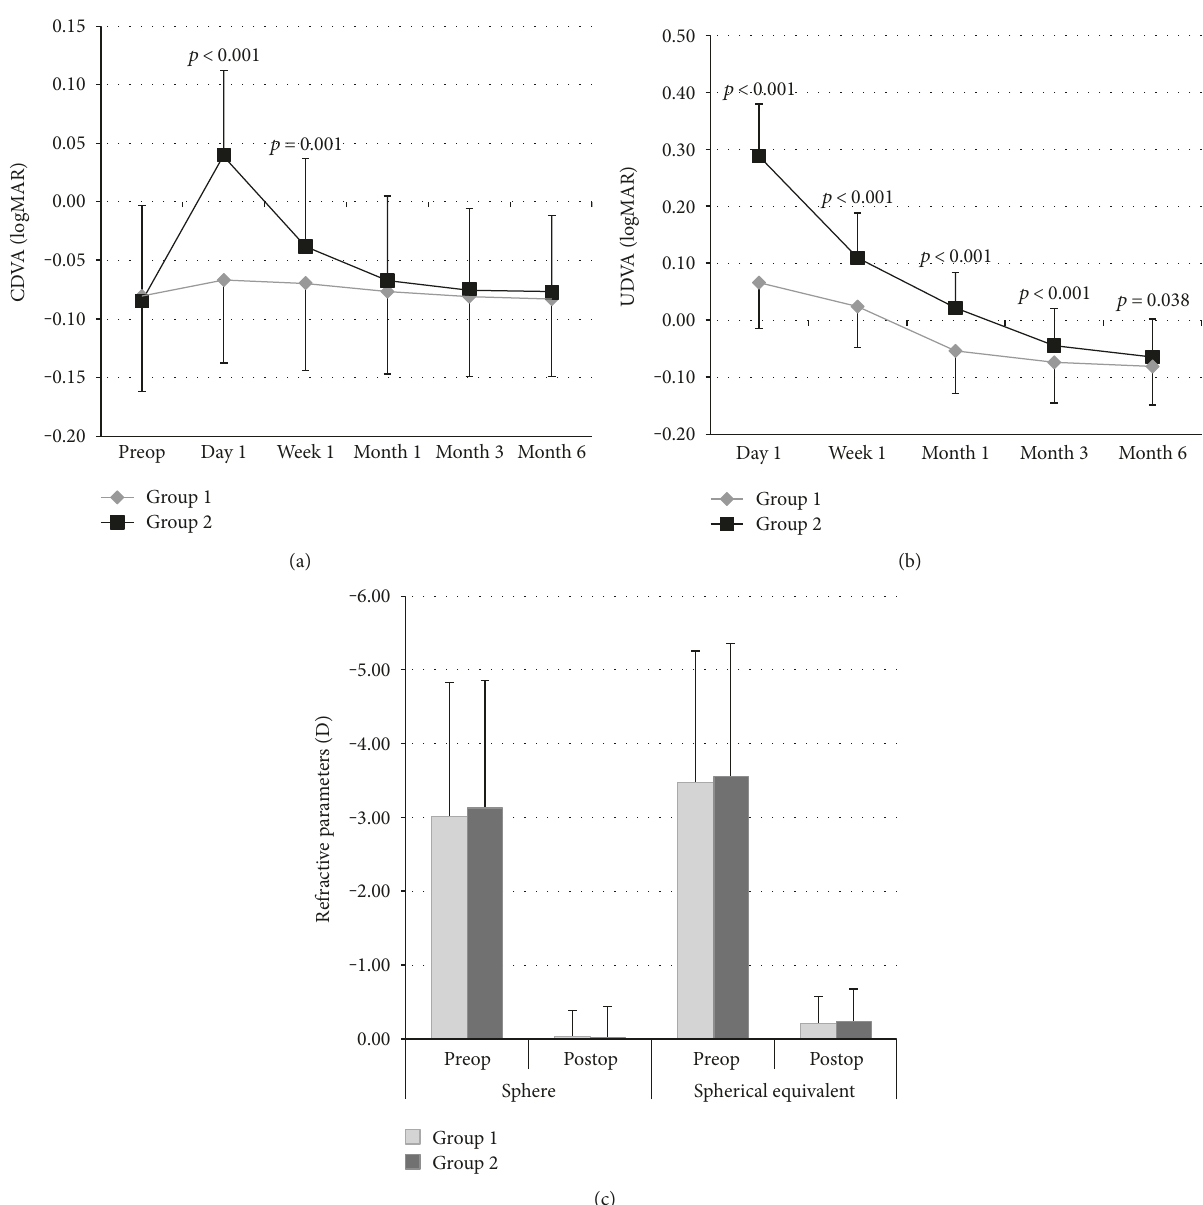
Figure 1: The mean and CDVA (a) and UDVA (b) in logMAR and sphere and spherical equivalent (c) in D of group 1 and group 2 during 6 months follow-up after SMILE procedure. The mean UDVA was signi fi cantly higher in all time points, as the mean CDVA was signi fi cantly higher in day 1 and month 1 postoperatively in group 2 than in group 1. SMILE provided statistically signi fi cant correction in both sphere ( p < 0 001 ) and spherical equivalent ( p < 0 001 ) in both groups. But both did not show signi fi cant di ff erence between groups before and after the SMILE procedure ( p = 0 582 and p = 0 943 , resp.). CLDD: cap-lenticule diameter di ff erence; CDVA: corrected distance visual acuity; UDVA: uncorrected distance visual